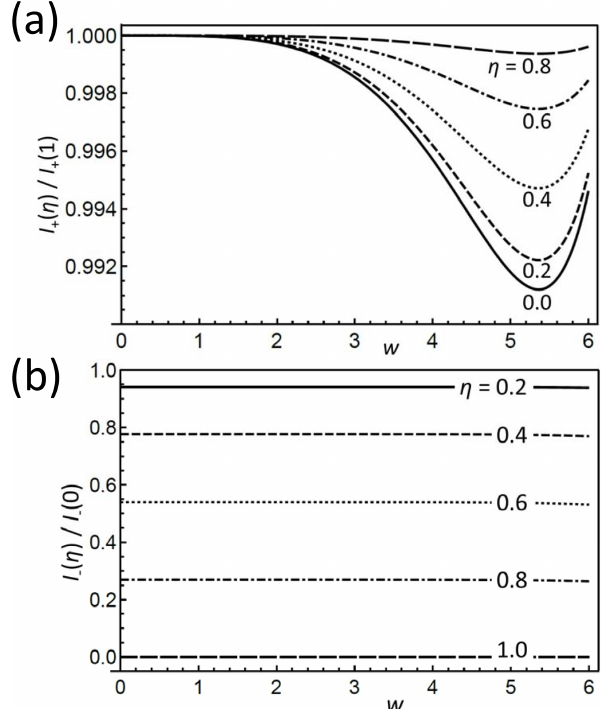
Figure 3. (a) I + and (b) I − for different η , normalized to their values at η = 1 and η = 0, respectively, as a function of w . Note the smallness of the differences between the I + curves in (a) of different η ; they are less than 1%. Remarkably in (b) is the almost independent ratio between the I − of different η